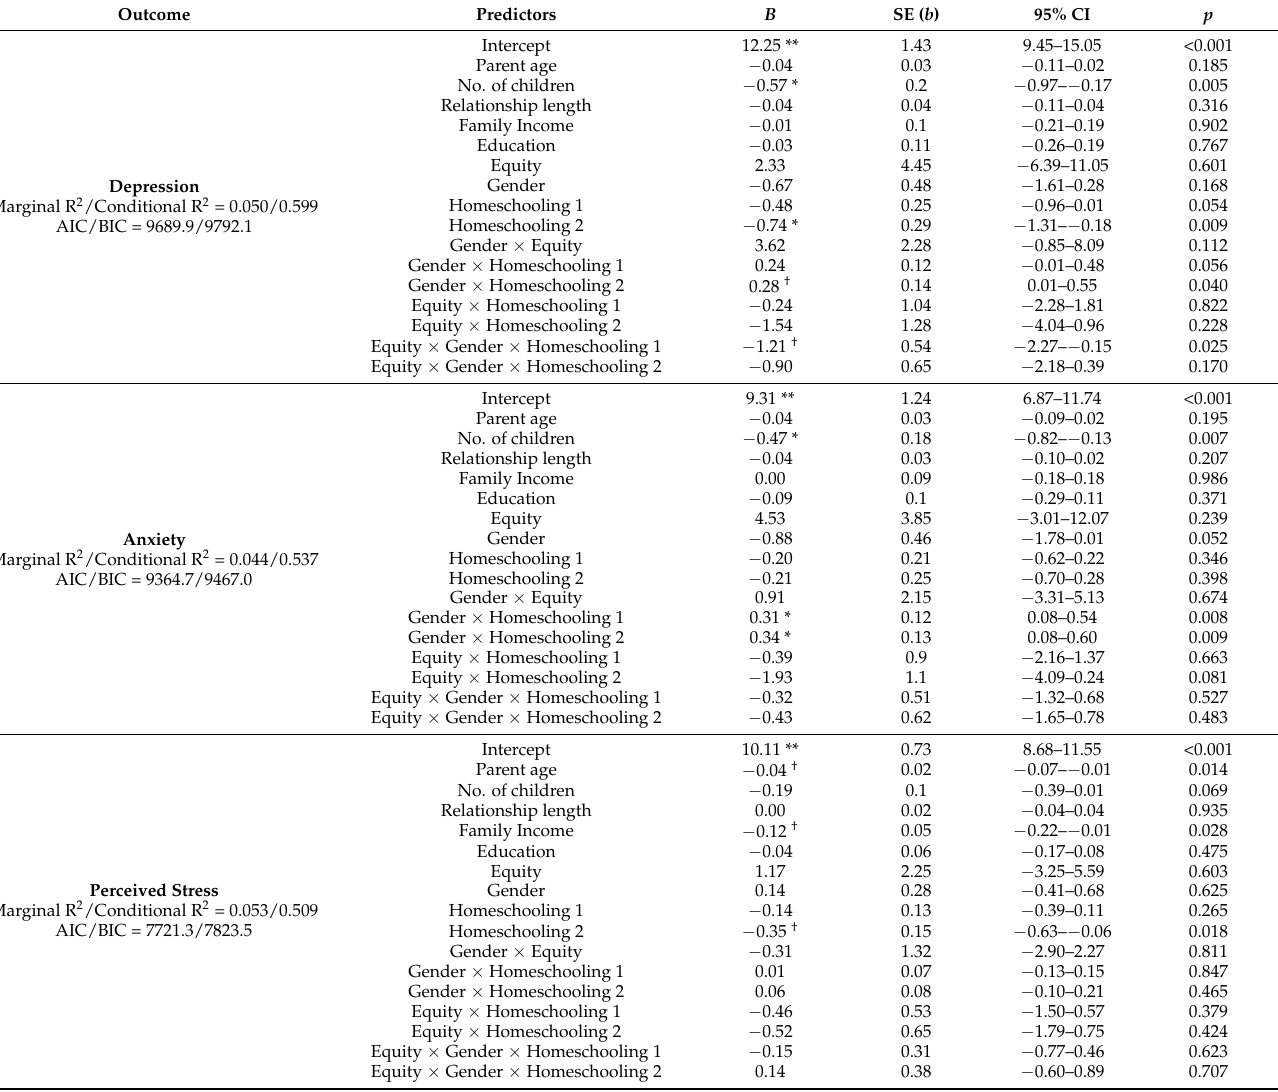
Table 10. Effects of equity and homeschooling status on male vs. female parents’ well-being in mixed-sex